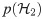
Bayesian decay model selection.In (a) an intensity image having pixels with intensity of about 750 photon counts, those on the left half of the image simulating a mono-exponential decay and those on the right half of the image simulating a bi-exponential decay; in (b) and (c) the Bayesian determined probability of the decay model being bi-exponential, p(H2), and the optimal decay model, H⋆, respectively, and in (d) the optimal model as determined by the χ2 model selection algorithm of [38] using the ML parameter estimates. Similar images are shown for human cancer cells expressing GFP (e-h), showing largely mono-exponential characteristics, and for human breast cancer tissue (i-l) which has many ‘contaminants’ from heterogeneous tissue types giving rise to bi-exponential, or higher order, responses. See main text for details.